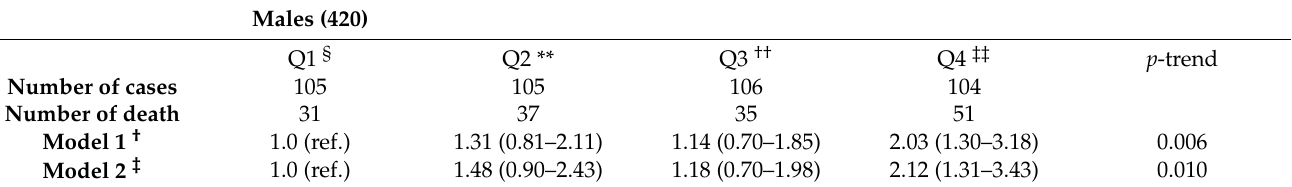
Table 2. Association between FVC% predicted divided into quartiles and mortality *.